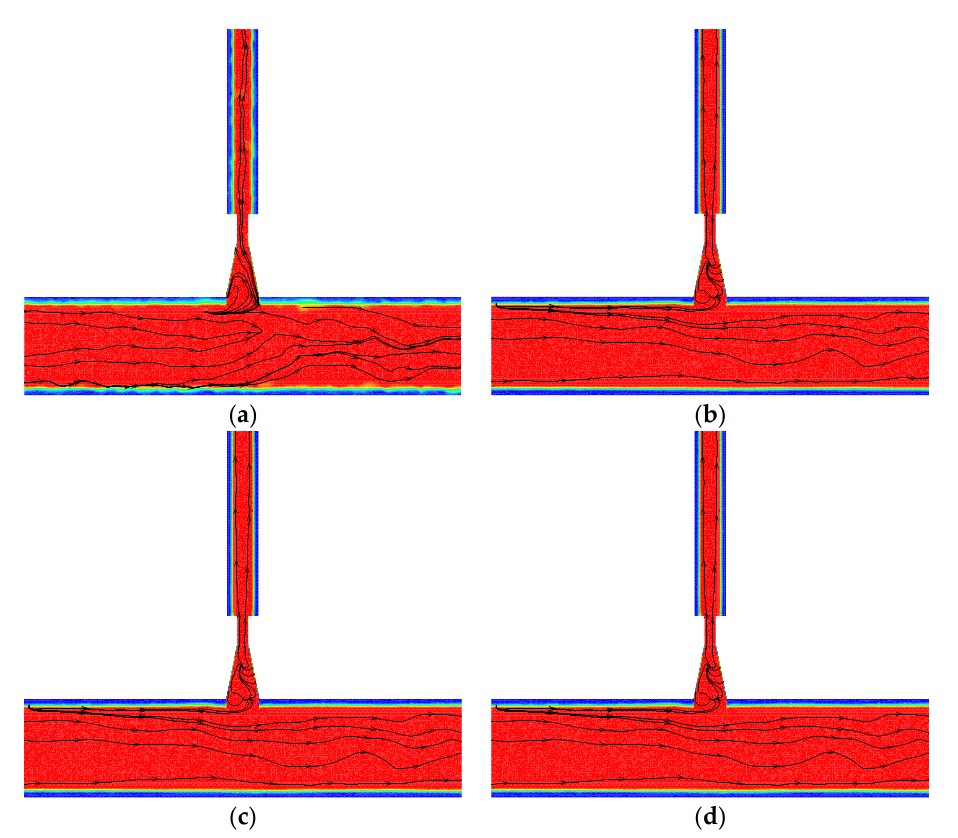
Figure 6. Numerical simulation results of the 4th channel for the water surface and streamline under opening degrees of ( a ) 0.2, ( b ) 0.4, ( c ) 0.6, and ( d ) 0.8. Table 3. Absolute errors of the numerical and experimental values.